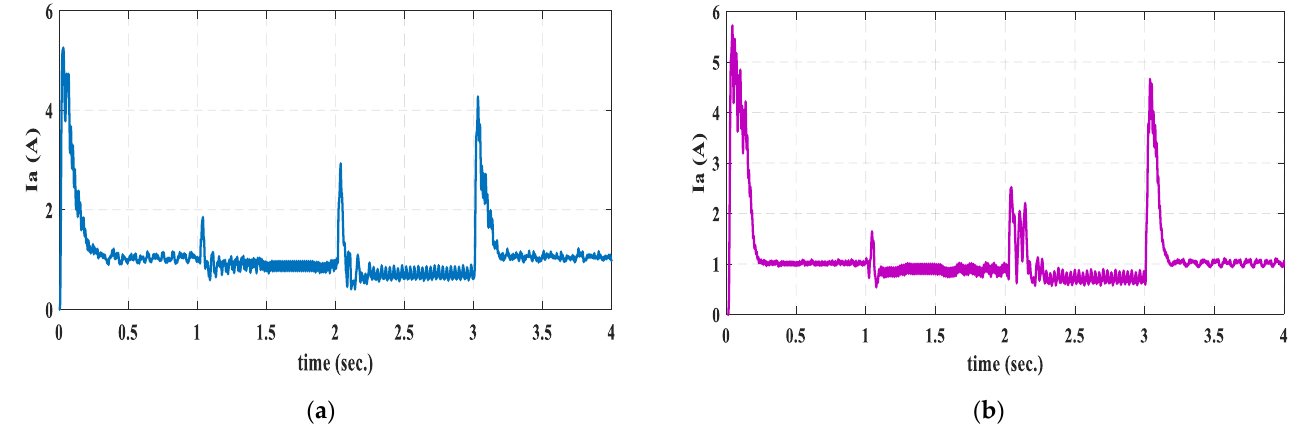
maximum torque is 0.29. Figure 11. Stator phase current–time response: ( a )with 3-phase inverter and transformer,( b )with 6-phase inverter. Figure 11. Stator phase current–time response: ( a ) with 3-phase inverter and transformer, ( b ) with 6-phase inverter.